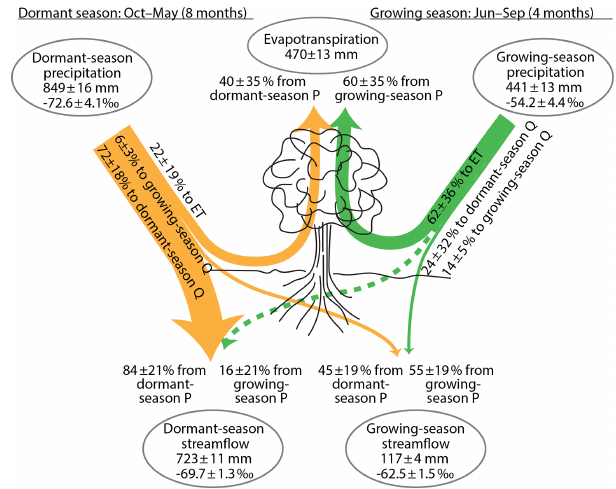
Figure 7. Partitioning of precipitation (P) into streamflow (Q) and evapotranspiration (ET) during the dormant season (October–May) and the growing season (June–September), inferred from annual water fluxes and volume-weighted δ 2 H at Hubbard Brook Water- shed 3. These two precipitation seasons are less isotopically dis- tinct than the rainy/snowy seasons (see Fig. 3), so the propagated uncertainties are correspondingly larger than those shown in Fig. 4. Evapotranspiration is mostly derived from growing-season precipi- tation, with a smaller fraction coming from dormant-season precip- itation, but both percentages are highly uncertain. Most growing- season precipitation is eventually evapotranspired, with a small but well-defined fraction eventually becoming growing-season stream- flow. Roughly half of growing-season streamflow is derived from a small but well-defined fraction of dormant-season precipitation. Most of the rest of dormant-season precipitation eventually be- comes dormant-season streamflow, and about one-fifth may evap- otranspire (although this is highly uncertain). All quantities are shown ± standard errors. Widths of lines are approximately pro- portional to water fluxes. Fluxes within 1 standard error of zero are shown by dashed